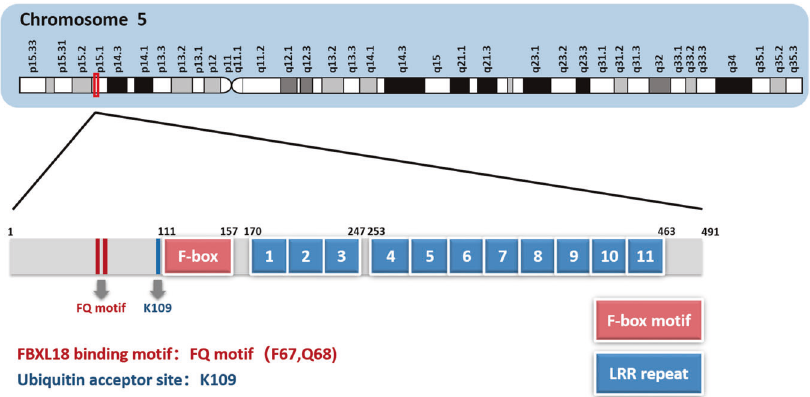
Fig. 1 The domain structures of FBXL7. FBXL7 , located on chromosome 5p15.1, encodes a 491 amino-acid protein that consists of an F-box motif for SKP1 binding and 11 LRR repeats at the C-terminus. The FQ motif for FBXL18 binding and ubiquitination modi fi cation site on K109 are indicated. LRR: leucine-rich